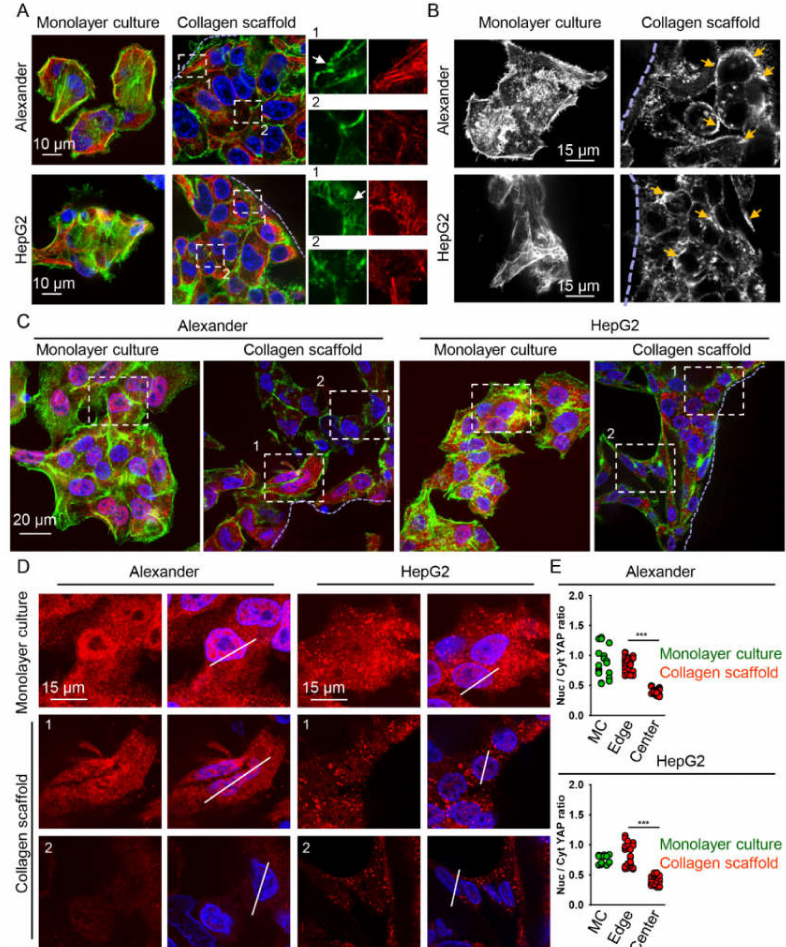
Figure 4. YAP cytosolic translocation under culturing in collagen sca ff olds. ( A ) HepG2 and Alexander cells were grown either in standard monolayer culture or in collagen sca ff olds. F-actin was labeled using ActinGreen ™ 488 ReadyProbes ™ reagent (green). Tubulin (red) was labeled using anti- β -tubulin antibody. Hoechst 33342 (blue) dye was used to counterstain nuclei. Labeled cells were then imaged by confocal microscopy and the images were processed using ImageJ software (NIH). Inserts represent zoom regions. The dashed lines highlight the collagen fiber–cells interface. Arrows indicate structures resembling filopodia. ( B ) Confocal fluorescence images (maximum intensity projection) of HepG2 and Alexander cells were grown either in standard monolayer culture or in collagen sca ff olds for 7 days. F-actin was labeled using ActinGreen ™ 488 ReadyProbes ™ reagent. Labeled cells were then imaged by confocal microscopy and the images were processed using ImageJ software (NIH). The dashed lines highlight the collagen fiber–cells interface. Arrows indicate spots of increased F-actin tension. ( C ) Assessment of YAP sub-cellular localization. HepG2 and Alexander cells were grown either in standard monolayer culture or in collagen sca ff olds. F-actin was labeled using ActinGreen ™ 488 ReadyProbes ™ reagent (green). YAP (red) was labeled using antibody. Hoechst 33342 (blue) dye was used to counterstain nuclei. Labeled cells were then imaged by confocal microscopy and the images were processed using ImageJ software (NIH). The dashed lines highlight the collagen fiber–cells interface. ( D ) Zoomed regions from corresponding confocal microscopic images shown in ( C ). ( E ) Assessment of nuclear / cytosolic YAP ratio of HepG2 and Alexander cells grown monolayer culture (green) or in collagen sca ff olds (red). Sub-cellular localization of YAP under culturing in collagen sca ff olds was analyzed at the edge and in the center of the pores of the sca ff old. (***) p < 0.001 denotes significant di ff erences, n = 18–24 cells per